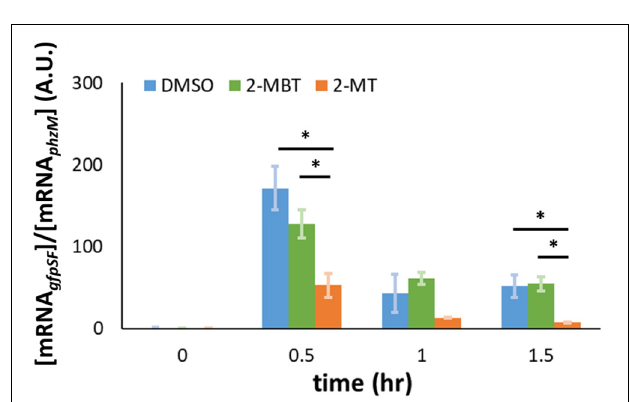
FIGURE 10 | Abundance of gfp SF mRNA in the presence of NO. gfp SF was expressed from the native hmp promoter (P hmp ) on pUA66. At time = 0, DPTA was added to achieve a final concentration of 250 µ M in bioreactors containing different compounds. At time points, samples were withdrawn from the bioreactors, and the abundance of mRNA gfpSF in those samples was measured by qPCR. Here, [mRNA gfpSF ] is normalized by [mRNA phzM ] to account for losses during purification. The solid bars represent the means of at least 3 independent experiments, and the error bars the standard errors of those means. Statistical significance, indicated by the asterisk signs (*), was determined by first running a one-way ANOVA test across all treatment conditions at the same time point. When the p -value from the ANOVA test was lower than 0.05, difference between groups were assessed by performing Tukey’s test, with a p -value threshold of